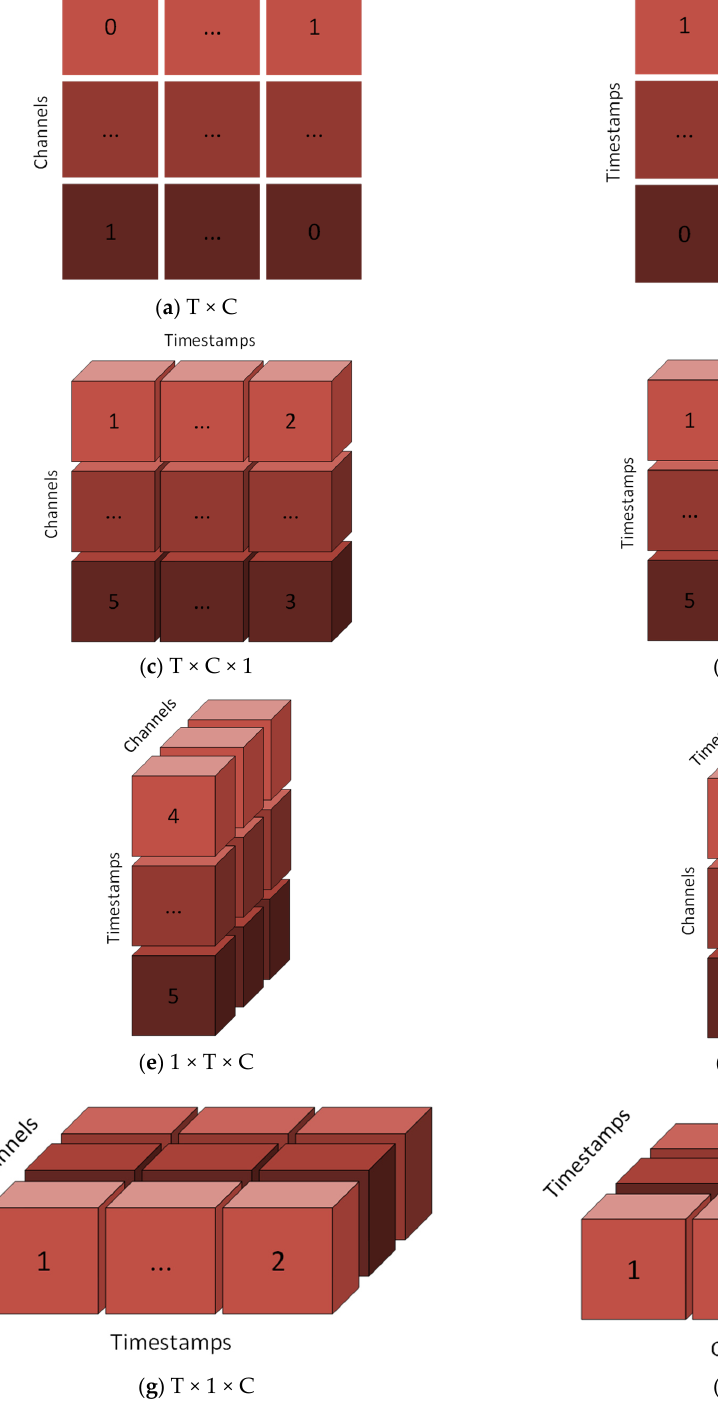
Figure 2. Input Shape Designs.